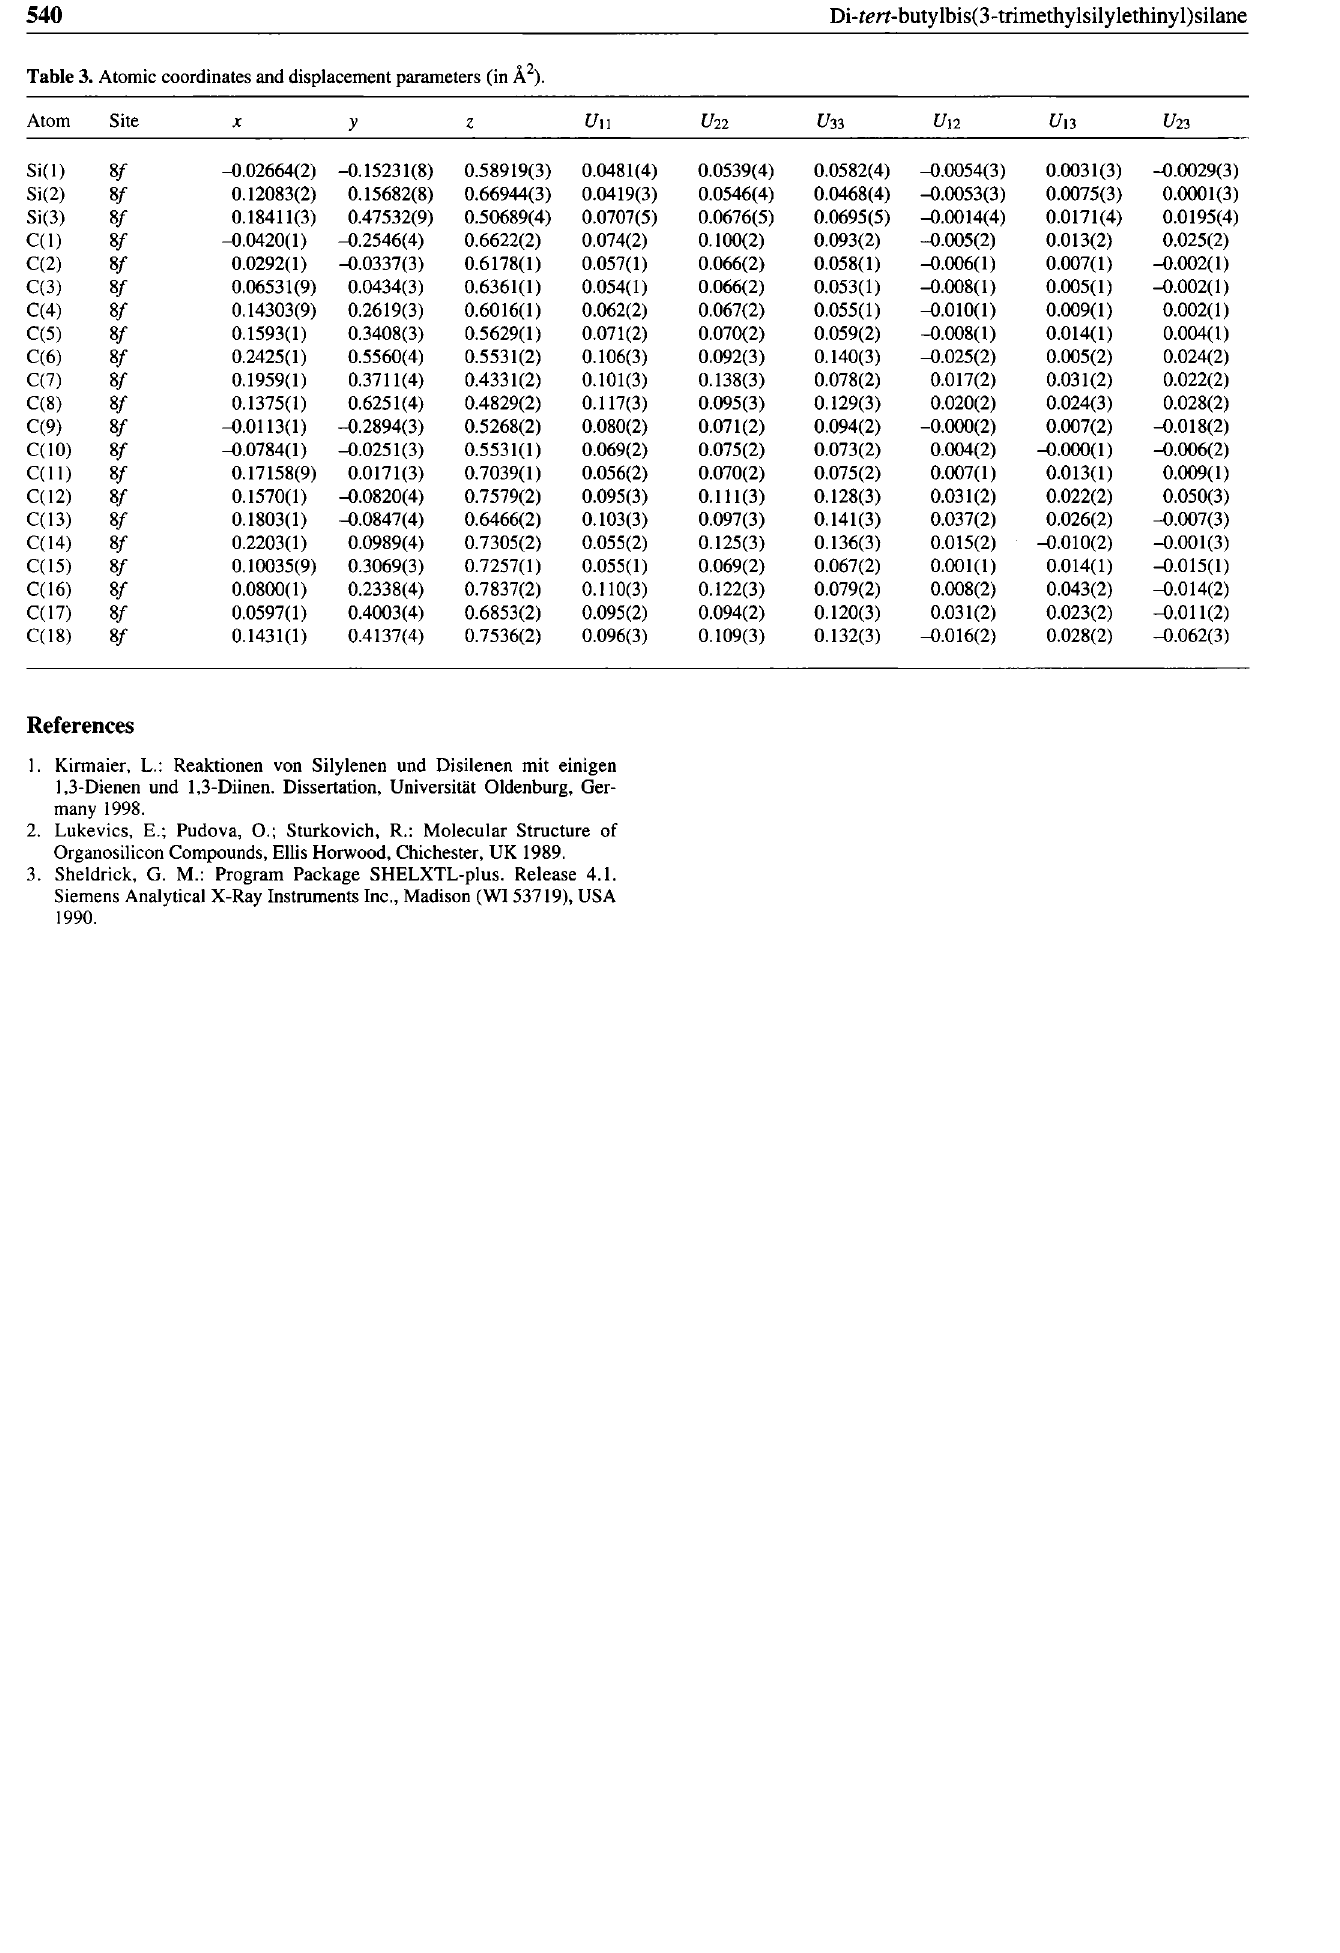
Table 3. Atomic coordinates and displacement parameters (in Ä 2